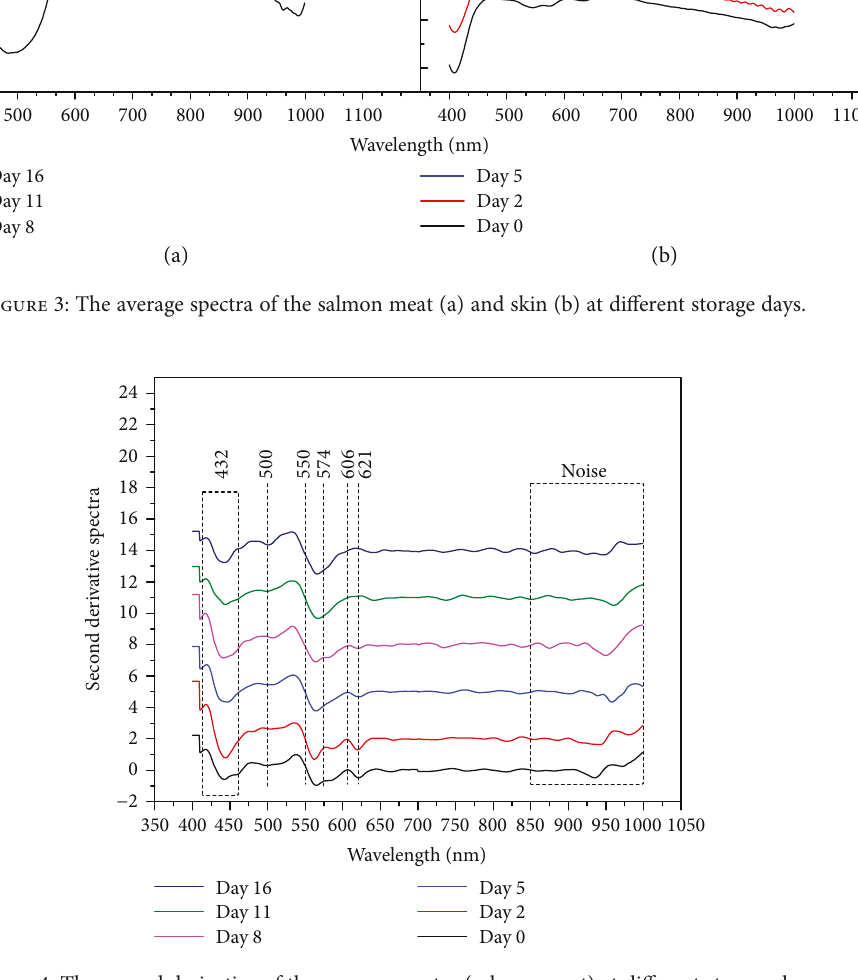
Figure 4: The second derivative of the average spectra (salmon meat) at di ff erent storage